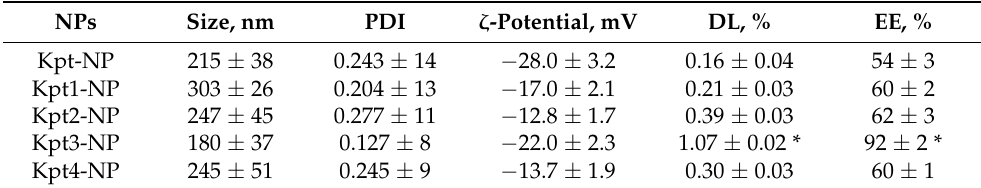
Table 3. Parameters of Kpt-NPs. Data shown as mean ± SD ( n = 3). NPs Size, nm PDI ζ -Potential, mV